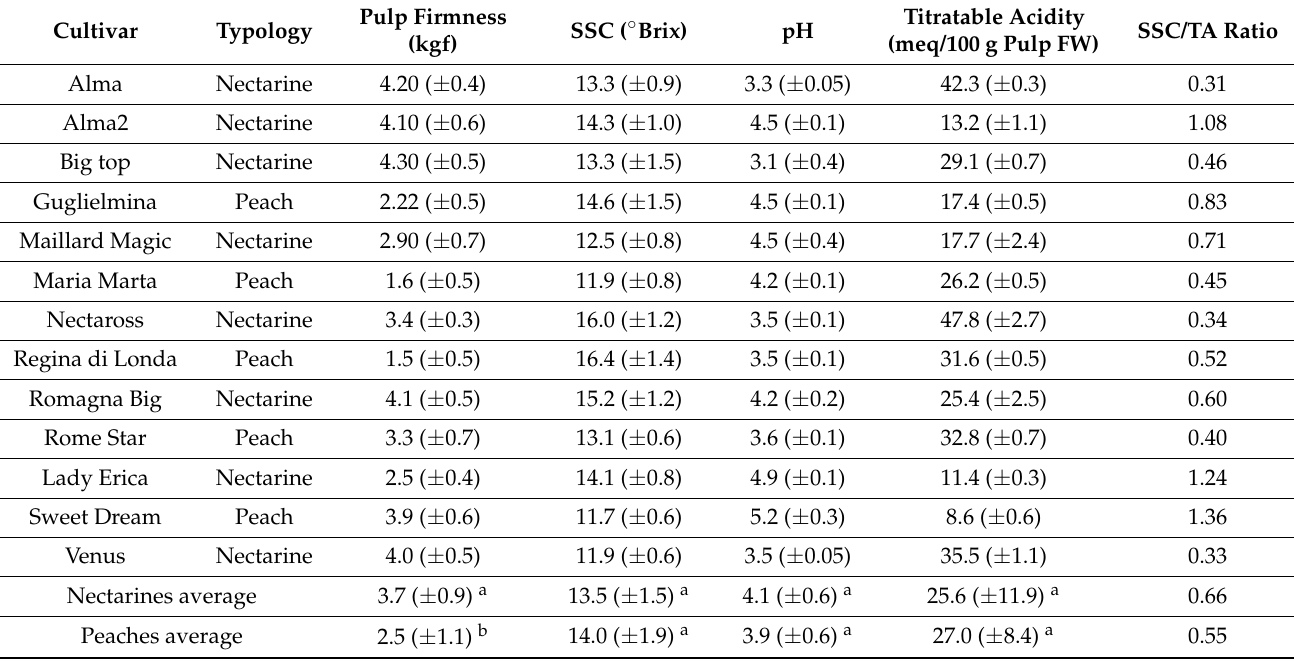
Table 2. Physicochemical parameters: pulp firmness (kgf), Soluble Solids Content (SSC, ◦ Brix), pH, Titratable Acidity (meq/100 g fresh pulp), SSC-TA ratio. Different letters in the same row (nectarine and peaches grand total) denote significant differences among samples means ( p < 0.01)